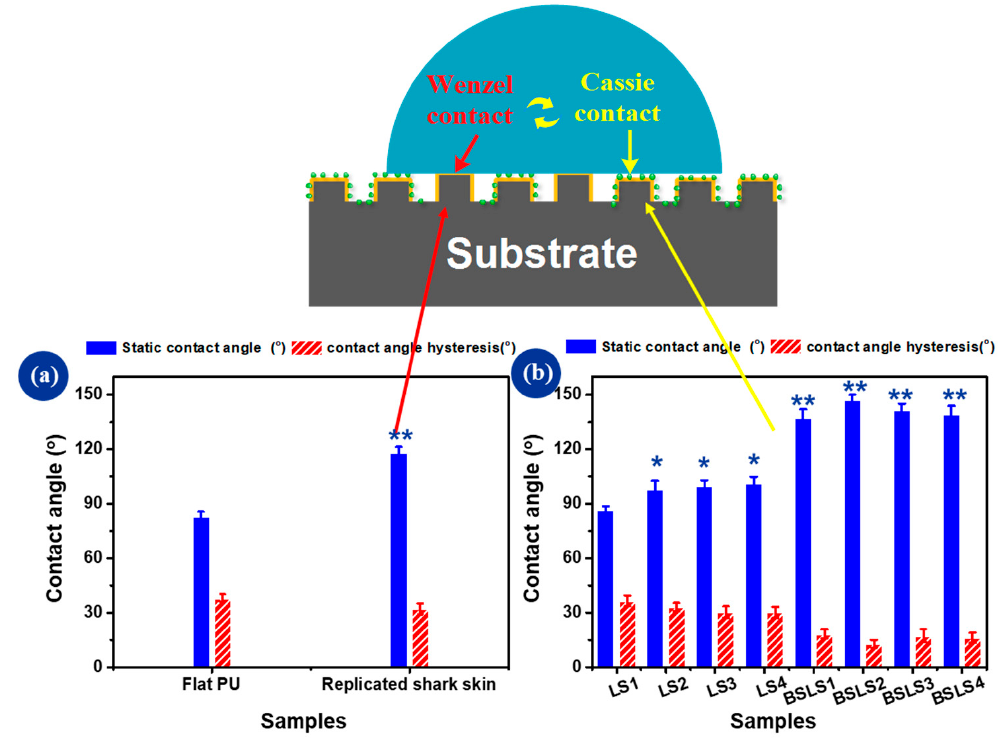
Figure 6. Bar charts showing the measured static contact angle and contact angle hysteresis. Four different spraying concentrations were used for the flat PU and replicated shark skin: 3.75, 4.25, 5, and 7.5 × 10 − 3 mg/mm 2 . Samples were denoted as lotus-like structure LS1–LS4 and BSLS1–BSLS4, respectively. ( a ) static contact angle and contact angle hysteresis for Flat PU and BS samples, ( b ) static contact angle and contact angle hysteresis after spraying SiO 2 *P < 0.05 different and **P < 0.01 significantly different from contact angle (CA) measured on flat PU by One-way ANOVA.